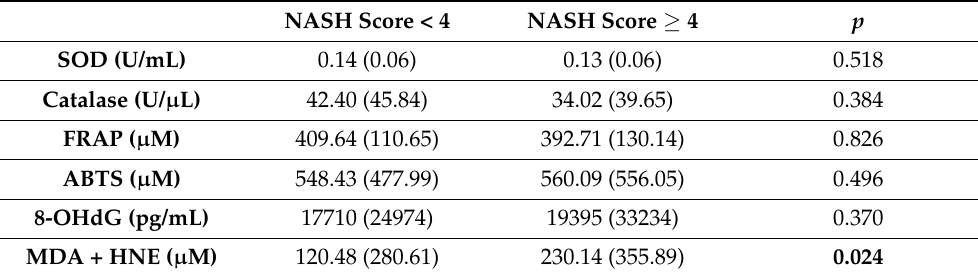
Table 2. Oxidative stress molecules’ levels in NAFLD patients split by a NASH score of 4. Data are represented as median and interquartile range (IQR).